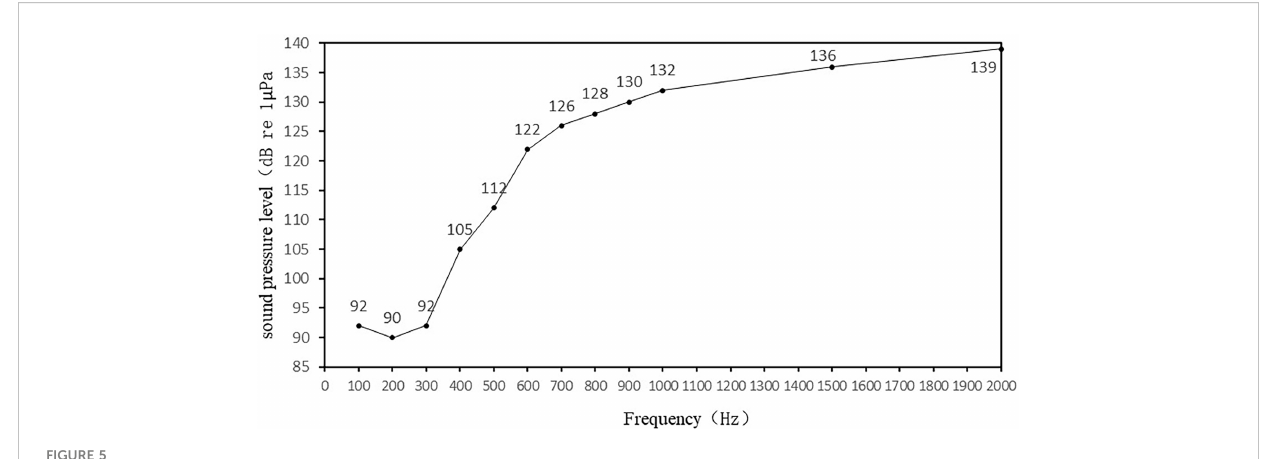
FIGURE 5 Auditory threshold curve of wild yellow